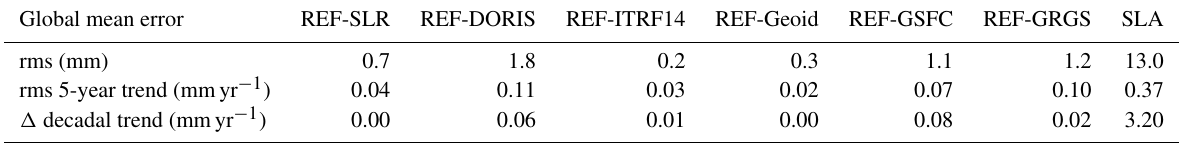
Table 4. Estimates of global mean orbit-related errors for the total signal, interannual, and decadal trends. Values are derived from the mean radial orbit differences over the oceans for REF minus SLR, REF minus DORIS, REF minus ITRF14, REF minus Geoid, REF minus GSFC, and REF minus GRGS for the period April 1993–June 2004. The corresponding values derived from the altimetric sea level anomalies (SLAs) are added for comparison. Details on the estimation method are given in Sect. 3.1.